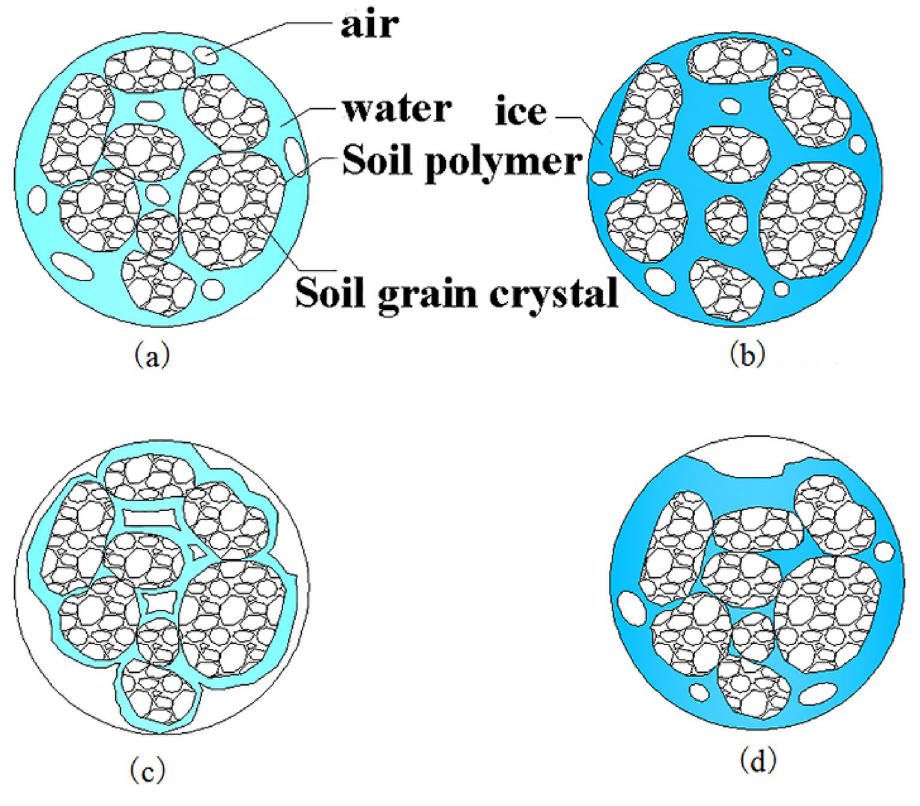
Figure 11. Pore changes in the soil during freeze–thaw cycling. ( a ) High moisture content (unfrozen); ( b ) high moisture (frozen); ( c ) low moisture (unfrozen); ( d ) low moisture